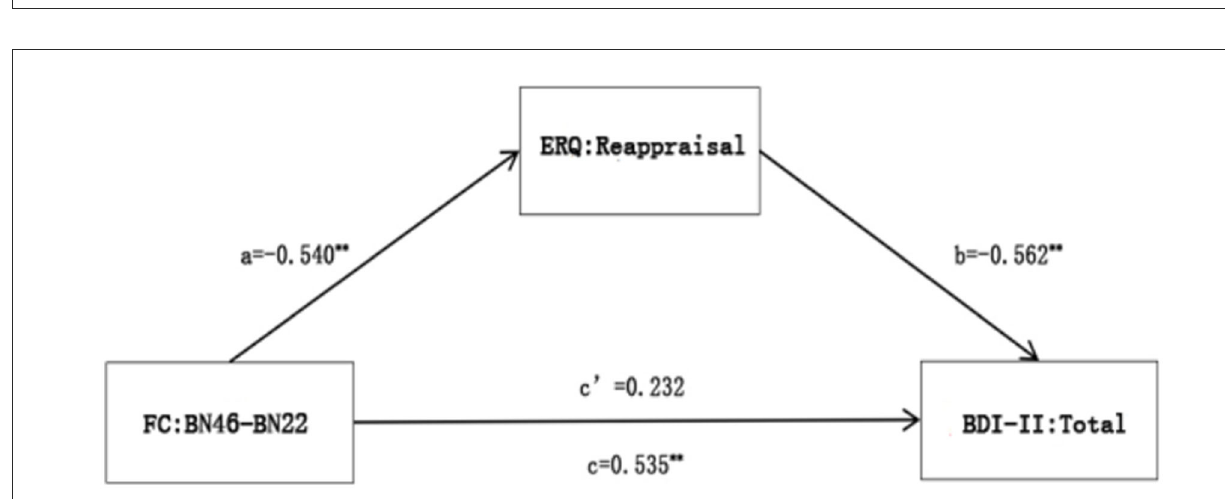
FIGURE3 A mediation analysis of FC: BN46-BN22 with ERQ reappraisal and BDI-II total. ** p <